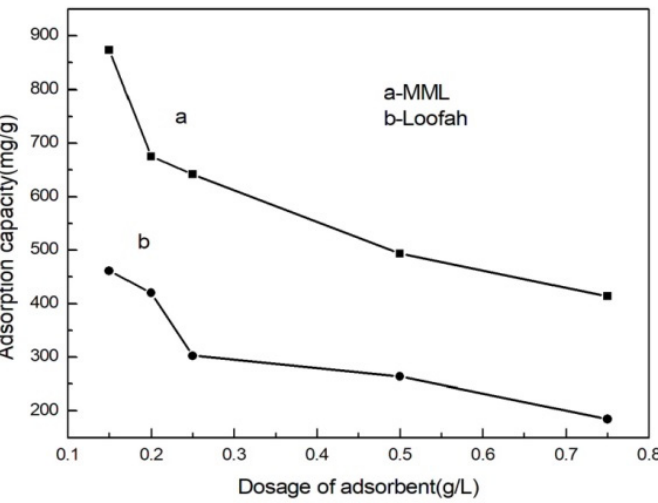
Figure 6. Relationship between the adsorption capacity of Cu(II) ions and the adsorption dose.